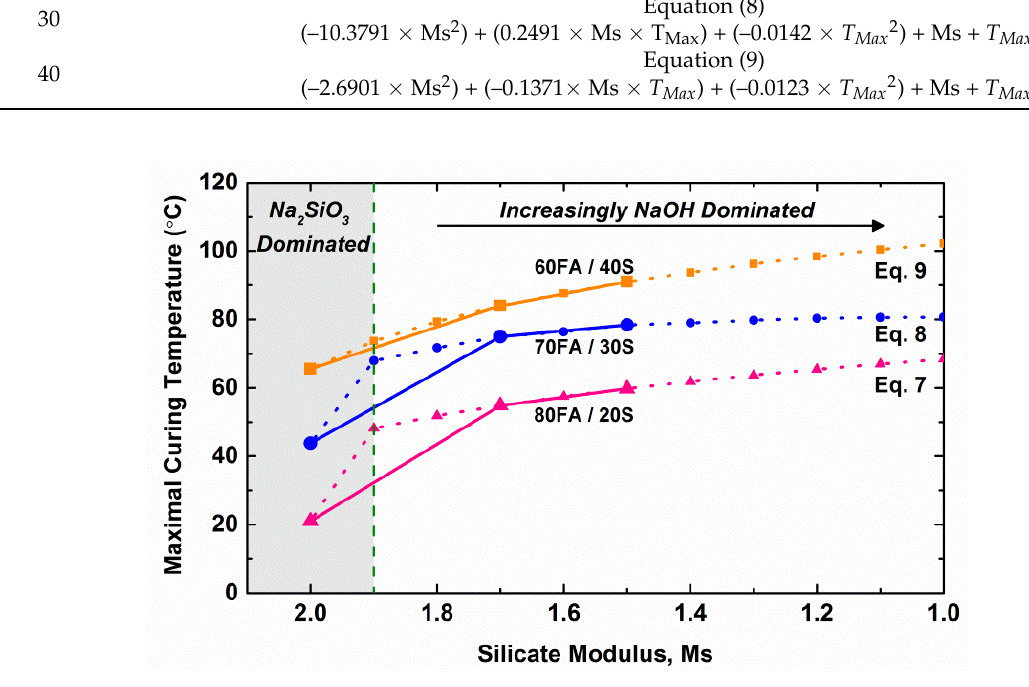
Figure 7. Data calculated from Figure 6 (solid lines) and values extrapolated using Equations (7)–(9) (dotted lines) for selected Ms values and slag contents (alkaline activator/SCM mass ratio = 0.5, water/binder ratio = 0.3).